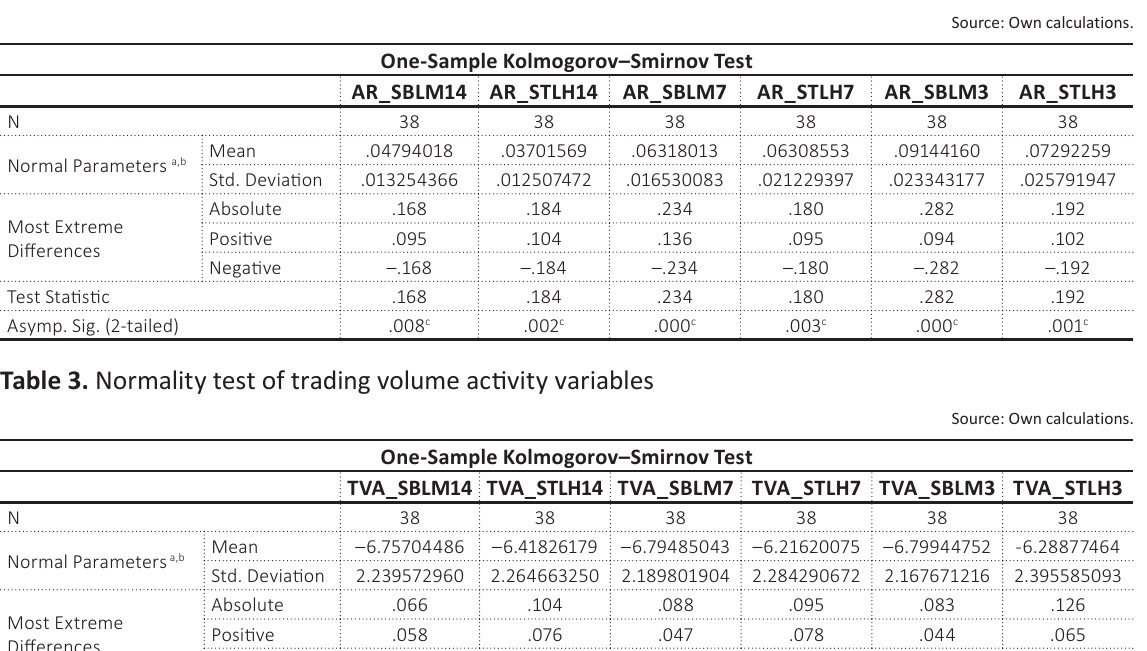
Table 2. Abnormal return normality test